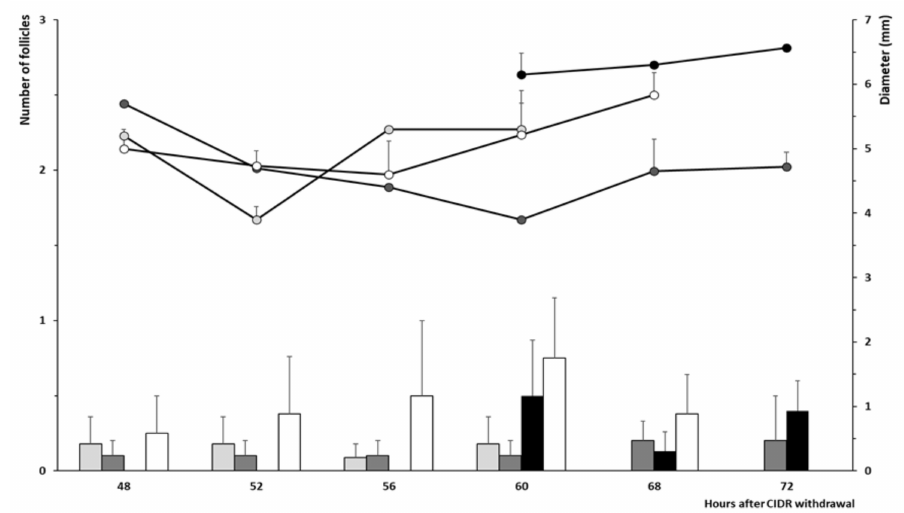
Figure 7. Mean number of ≥ 4 mm follicles (bars) and mean diameter of the largest follicle (lines) from 48 h after CIDR withdrawal to ovulation in ewes treated with 400 IU of eCG (at CIDR removal; group eCG, white bars and dots) or 50 µ g of GnRH in either distilled water (56 h after CIDR removal; group WAT56, black bars and dots) or propylene-glycol (24 or 36 h after CIDR removal; groups PPG24 and PPG36 with light grey and dark grey bars and dots,